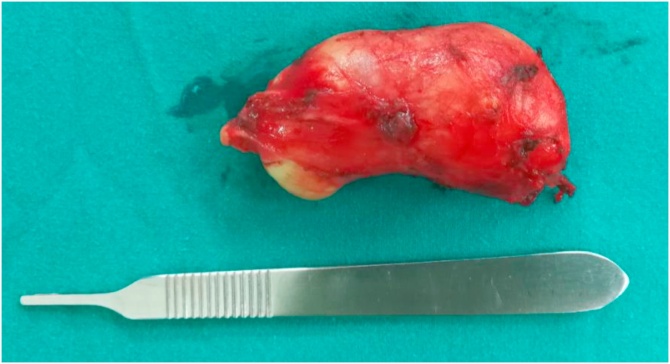
Surgical specimen.